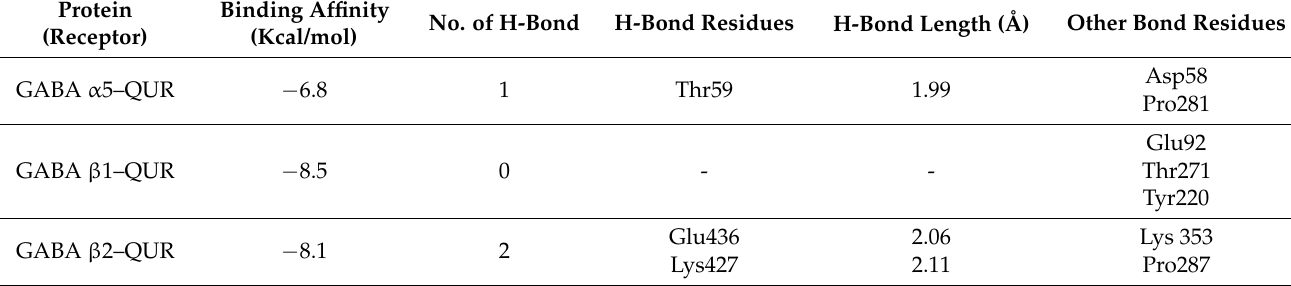
Table 5. The best three results of molecular docking study of quercetin (QUR) with GABA recep- tor